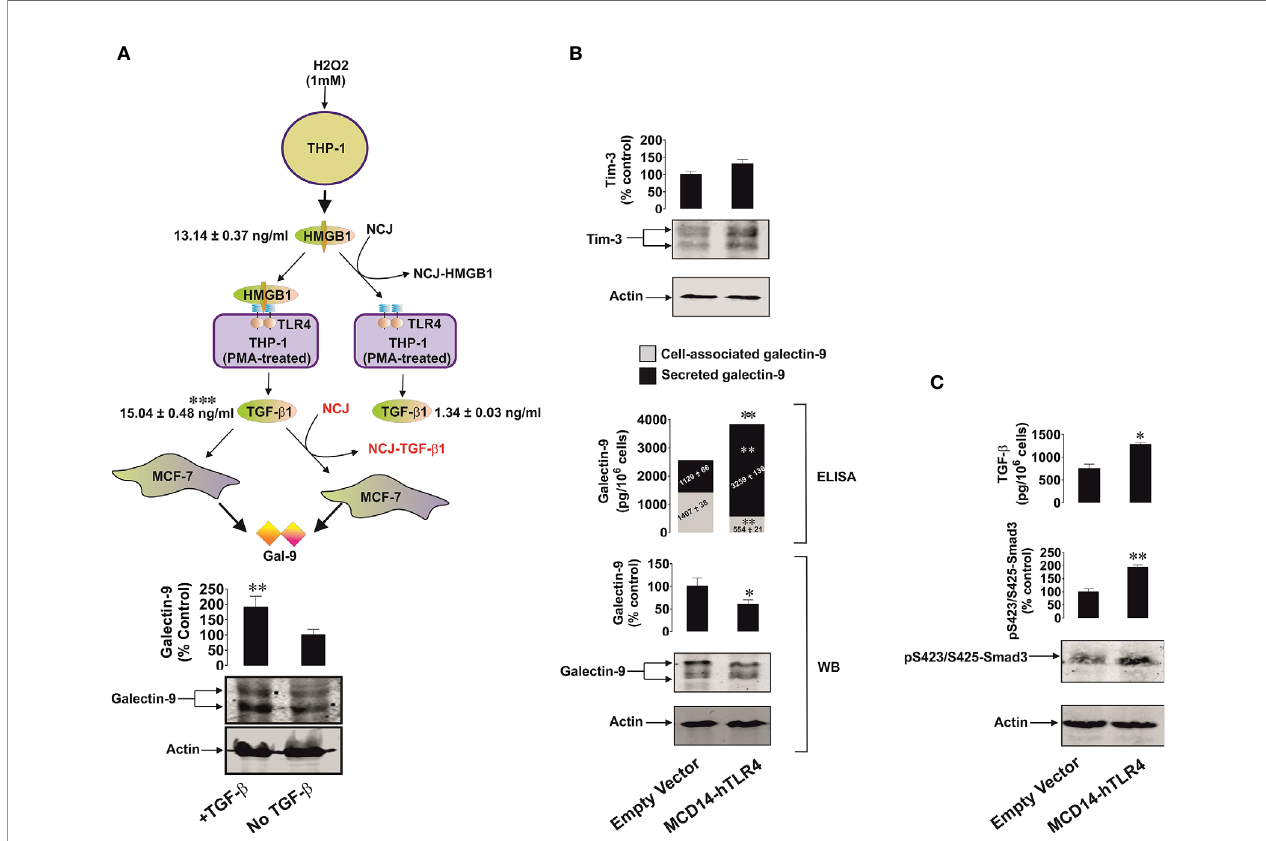
FIGURE 7 | TGF- b produced by TLR4 expressing cells upon stimulation with HMGB1 triggers galectin-9 expression in target cancer cells. Active TLR4 is capable of inducing the same effects without HMGB1. (A) THP-1 cells were treated with 1 mM H 2 O 2 for 24 h and the medium was collected for further use. This medium after H 2 O 2 degradation with or without immunoprecipitation of HMGB1 was used to treat PMA-differentiated THP-1 cells expressing high levels of TLR4 for 24 h. The medium from PMA-treated THP-1 cells treated with HMGB1-containing medium was collected. This medium with or without immunoprecipitation of TGF- b was used to incubate MCF-7 cells for 24 h followed by measurement of galectin-9 by Western blot. (B) Colo 205 cells were transfected with constitutively active TLR4 or corresponding empty vector followed by 24h of incubation without further treatment. Expression of Tim-3 protein and it ’ s secretion (values are presented in the text), galectin-9 protein expression by both Western blot and ELISA and secretion by ELISA were analysed. (C) TGF- b secretion and Smad3 activating phosphorylation were also detected. Images are from one experiment representative of 4 giving similar results. Quantitative data are shown as mean values ± SEM from 4 independent experiments. *p < 0.05 and **p < 0.01 vs